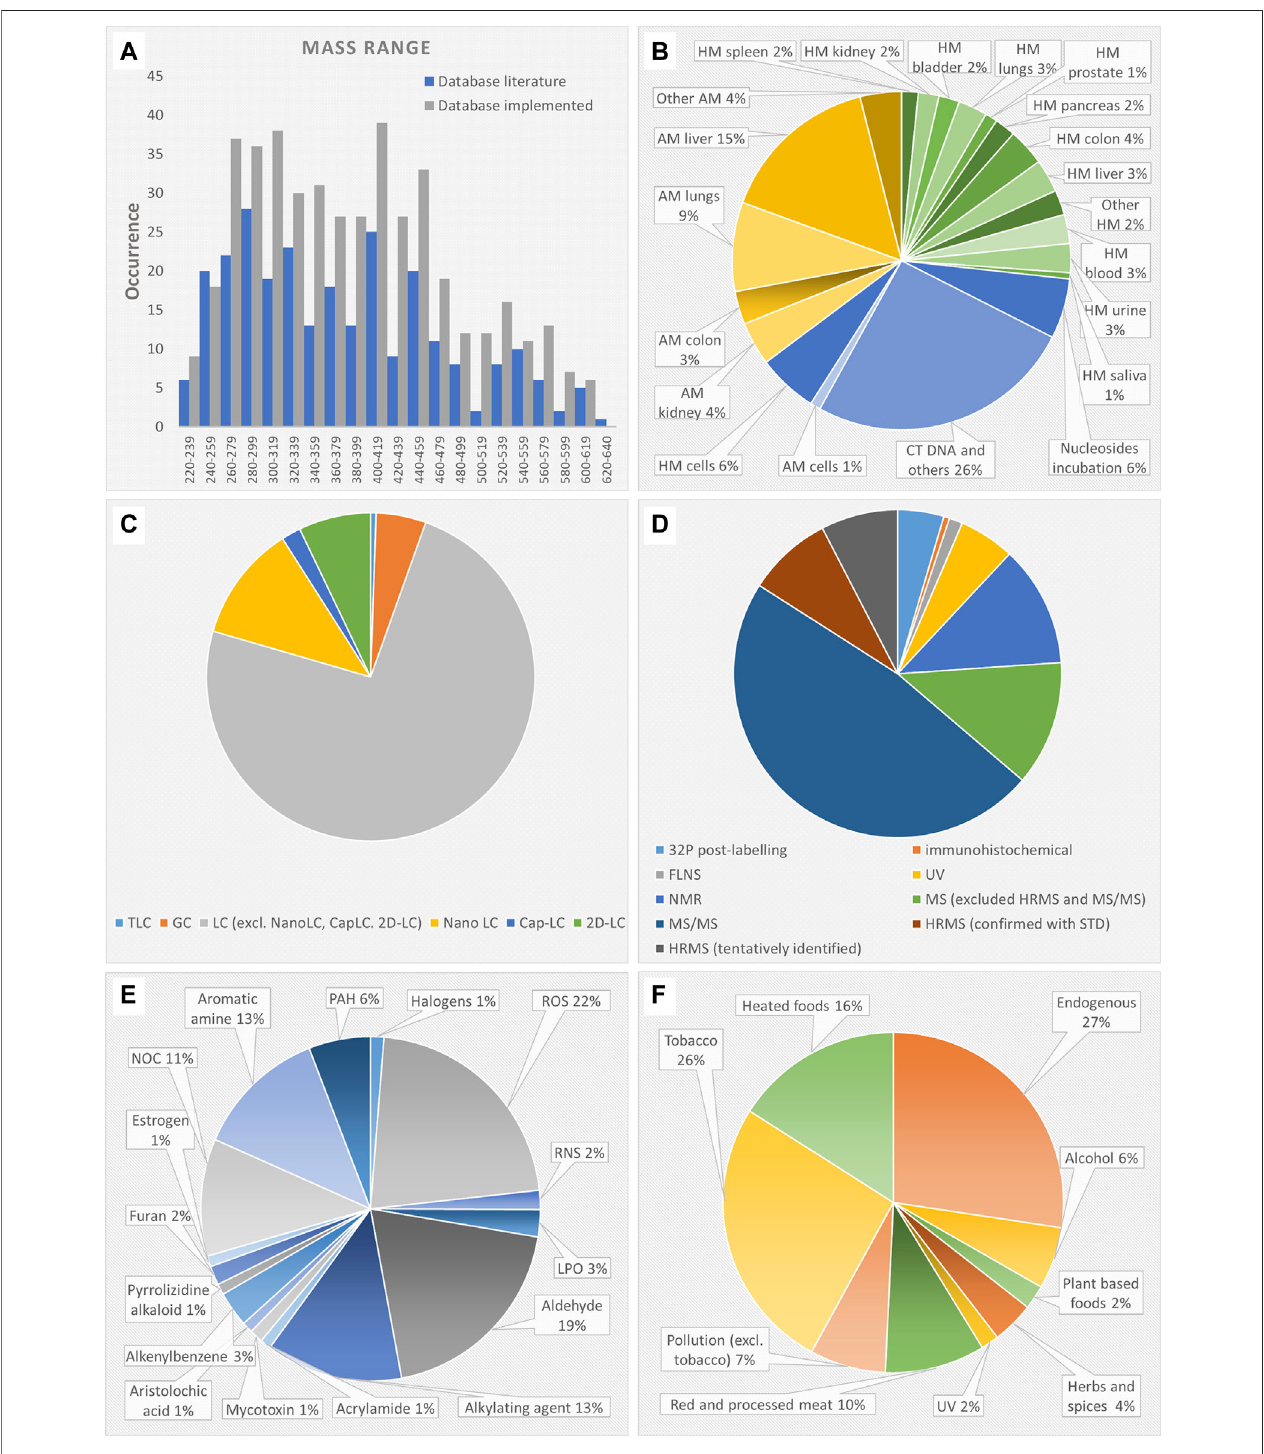
FIGURE 2 | (A) mass range distribution of the DNA adduct database before and after implementation with suspected DNA adducts; (B) samples where the DNA adductshavebeenanalyzed; (C) chromatographictechniqueusedforDNAadductanalysis; (D) techniqueusedforDNAadductidenti fi cation; (E) DNAadductcausative genotoxicants grouped in 16 classes where “ aromatic amines ” includes heterocyclic aromatic amines, “ LPO ” excludes aldehydes, i.e., α , β unsaturated aldehydes, malondialdehyde, formaldehyde, glyoxal, acrolein, crotonaldehyde, “ NOC ” includes N-nitroso pyrrolidine and nitrosamine; (F) sources of the causative genotoxicantsgroupedinnineclasses.Abbreviations:LC,liquidchromatography;MS,massspectrometry;capLC,capillaryLC;FLNS, fl uorescencespectrometry;GC, gas chromatography; HRMS, high resolution MS; MS/MS, tandem mass spectrometry; NMR, nuclear magnetic resonance; TLC, thin layer chromatography; HM, human; AM, animal; LPO, lipid peroxidation product; NOC, N-nitroso compounds; PAH, polycyclic aromatic hydrocarbons; RNS, reactive nitrogen species; ROS, reactive oxygen species.